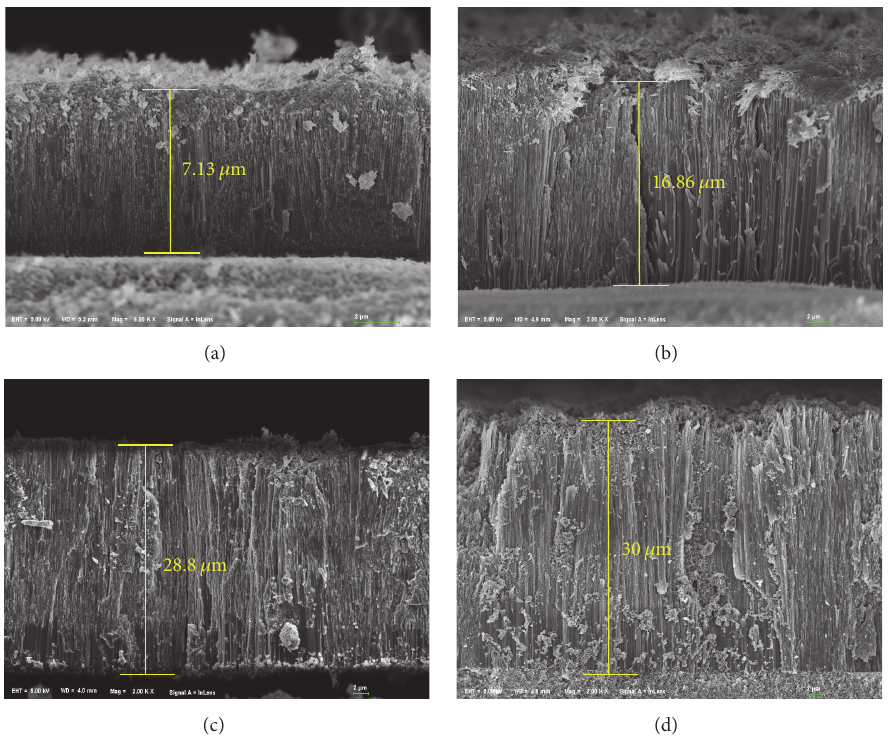
Figure 5: The cross-sectional SEM images of double-layer film with different anodization time: (a) 5h, (b) 12 h, (c) 18h, (d) and 22 h.